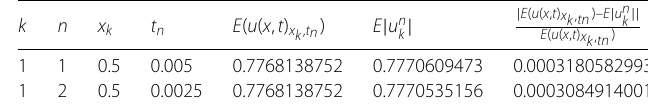
Table 3 β ∼ Binomial(1.0,0.5), α = 1